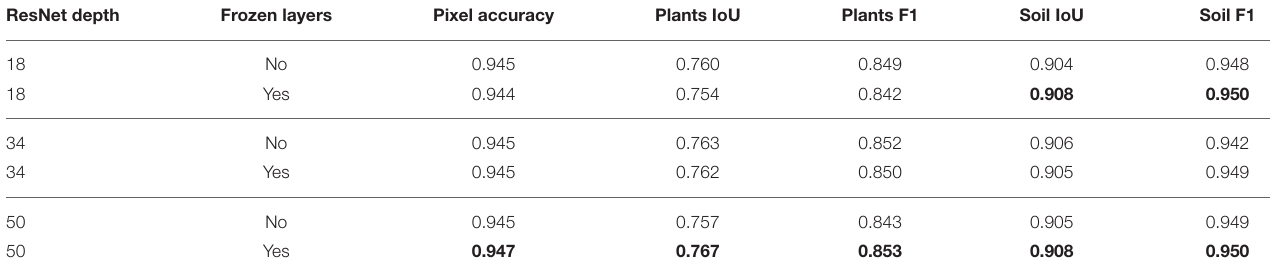
TABLE 4 | Influence of finetuning different ResNet encoder depths. ResNet